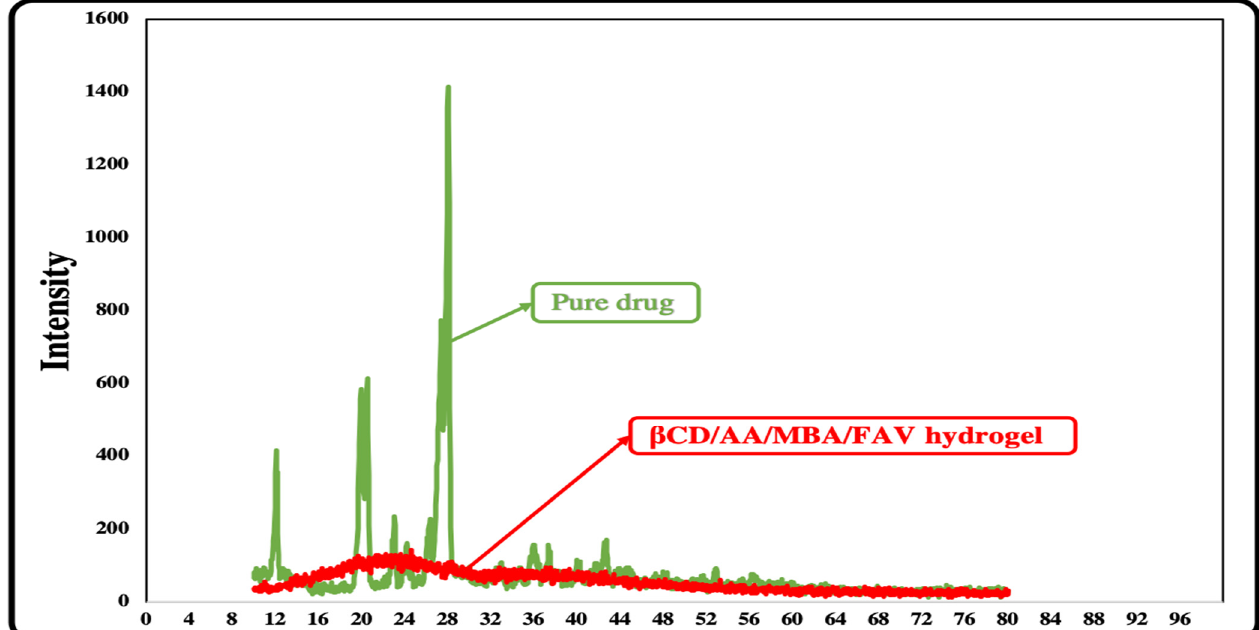
Figure 10. Illustrating XRD diffraction of pure drug (favipiravir) and β CD/AA/MBA/FAV hydrogel. The XRD of the pure drug shows sharp and intense peaks, indicating crystalline structure, but the XRD of the drug-loaded hydrogel shows no sharp peaks and crystalline structure, which indicates that crystallinity of the drug is masked in nanocomposite hydrogel form.